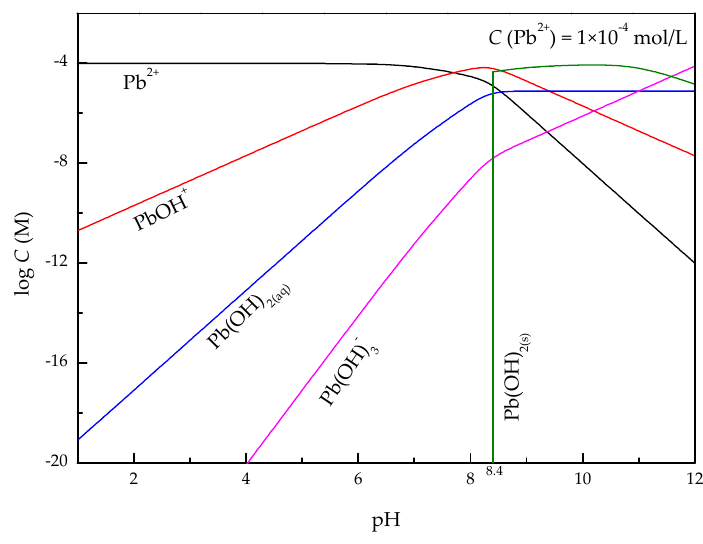
Figure 6. Logarithmic diagram of lead ions hydrolysis components.